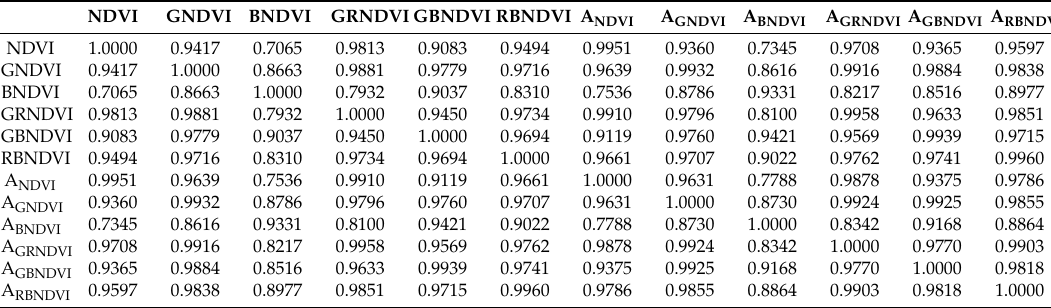
Table 2. Summary of correlation coefficients of NDVI and its derivative